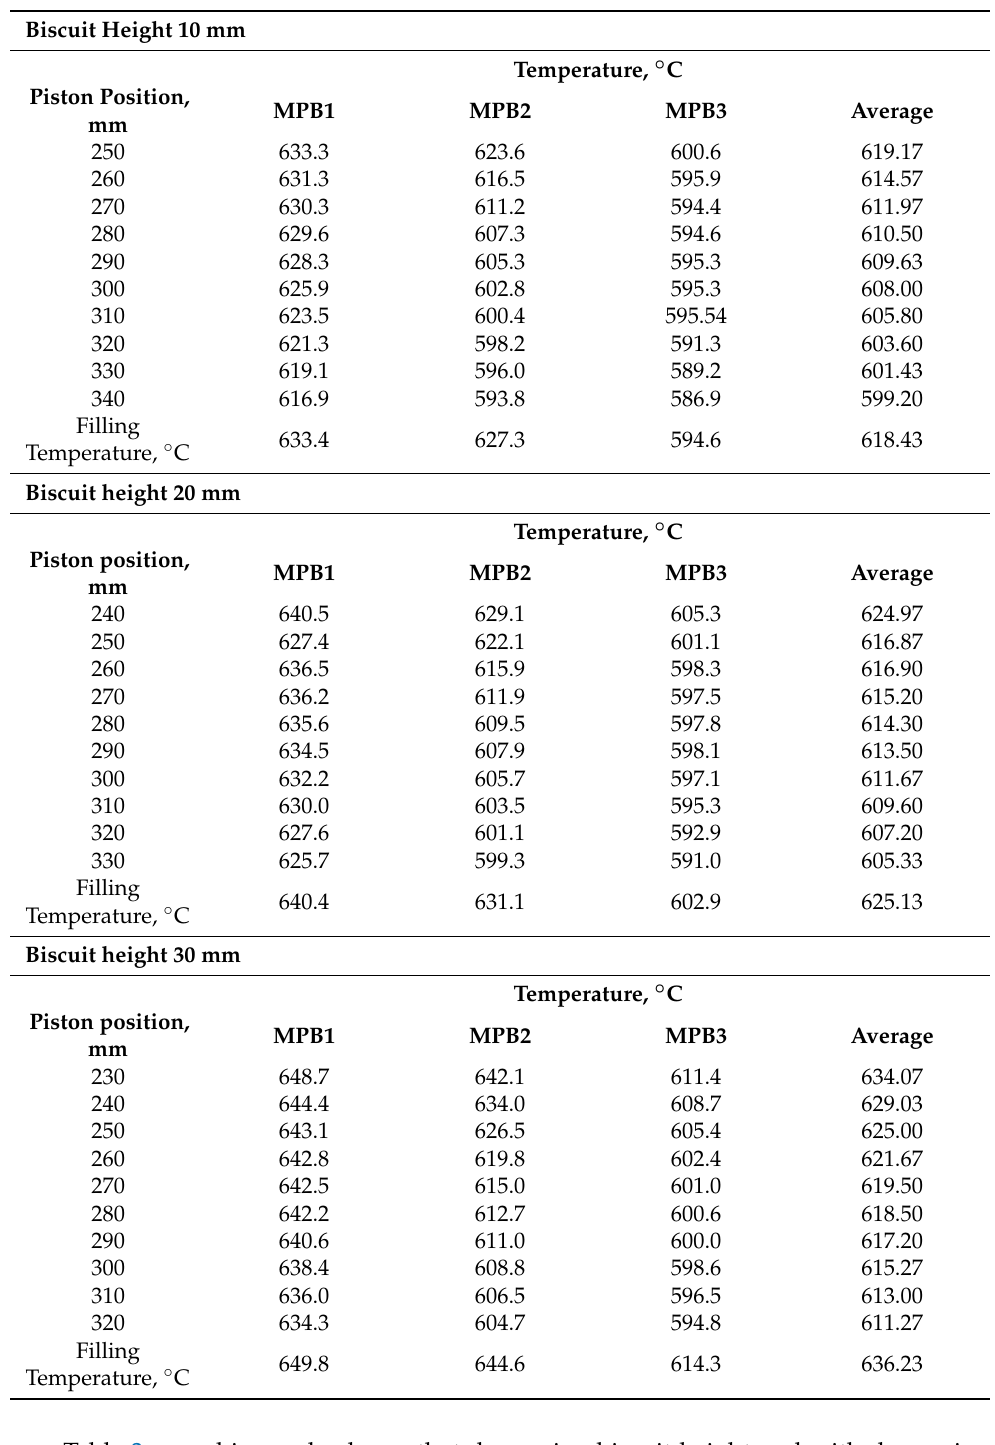
Table 3. Melt temperature in the area of the biscuit and its dependence on biscuit height